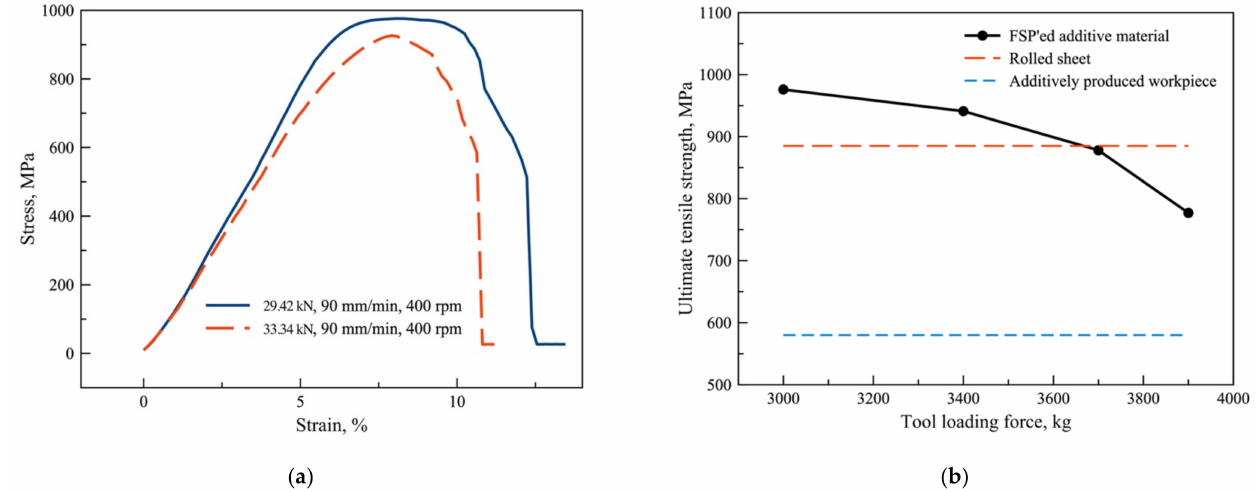
Figure 10. Stress-strain curves for additional samples, processed in the layer deposition direction ( a ); dependence of the Ti-6Al-4V stir zone ultimate tensile strength on the tool loading force ( b